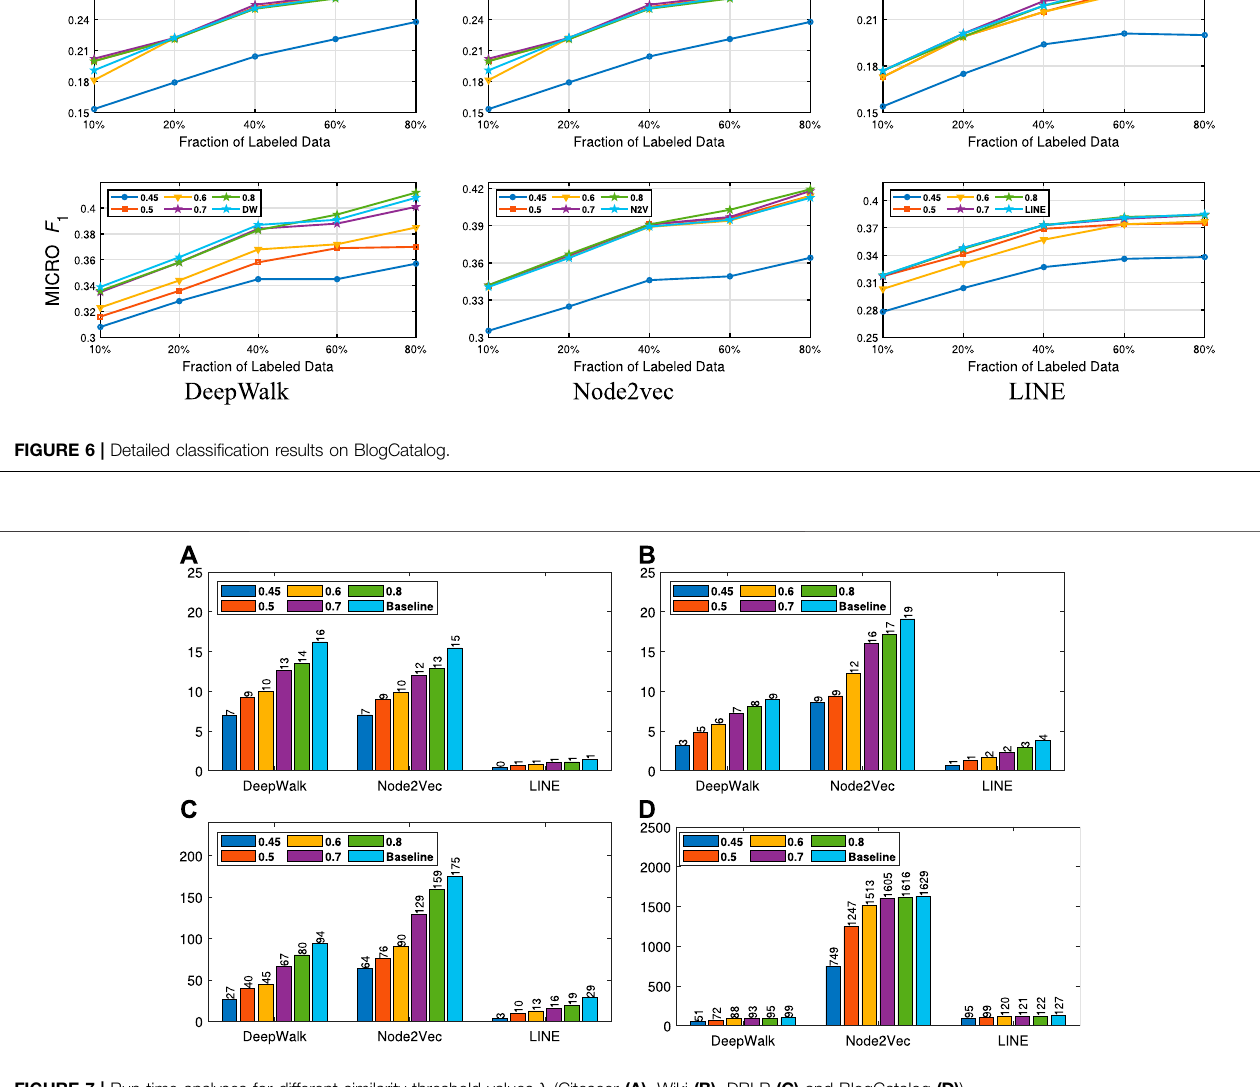
Frontiers in Big Data |